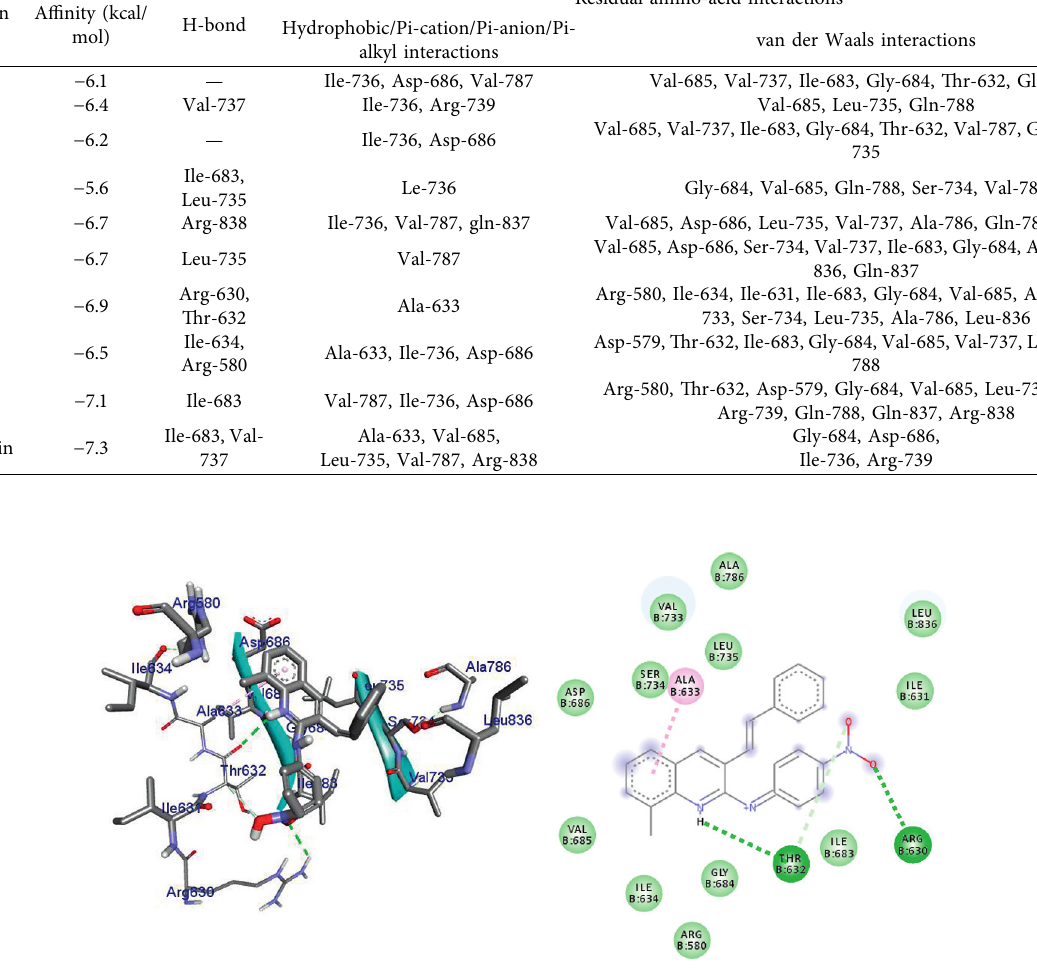
Figure 5: The binding interactions of compound 19 against E.coli DNA gyrase A (PDB ID: 1ZI0).